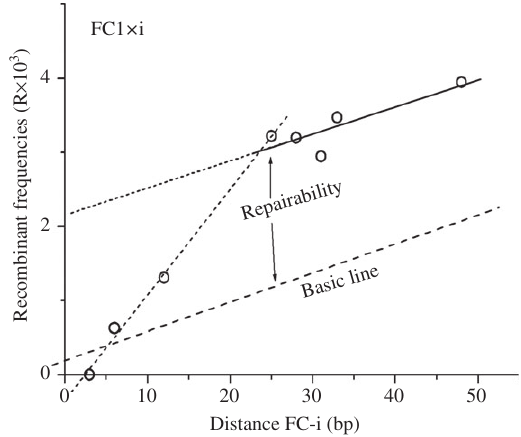
Figure 3 An example of measuring the repairability value and repair tract